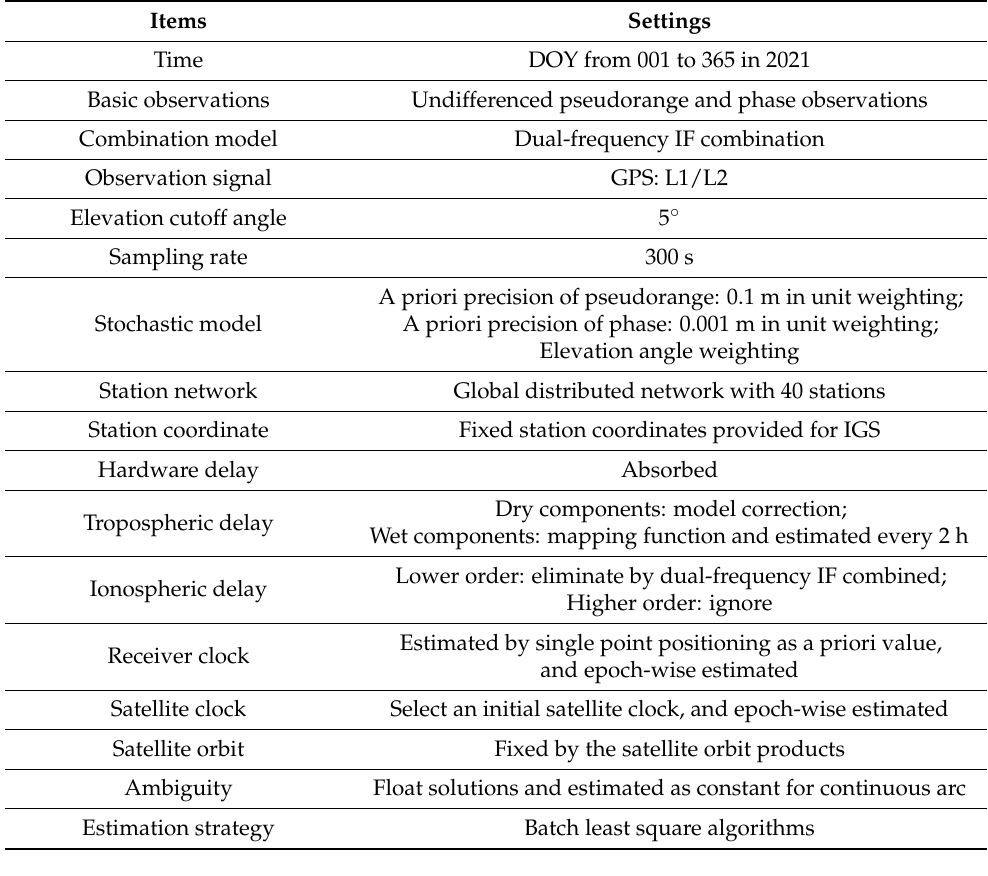
Table 1. Experimental setup and processing